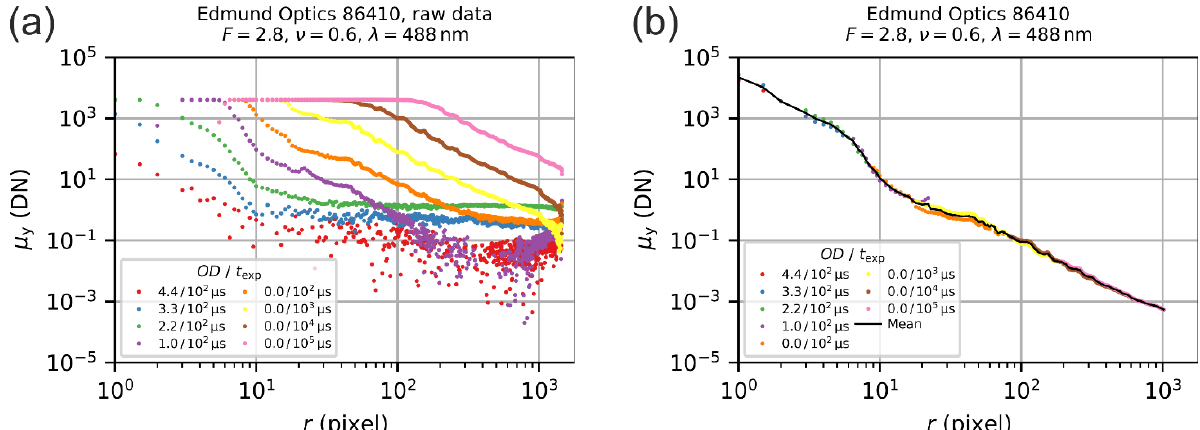
Figure 4. Example of the data analysis: ( a ) Result of the irradiance profile generation, ( b ) final result after averaging the partly overlapping single profiles. Based on Figures 11 and 12 of reference [22].